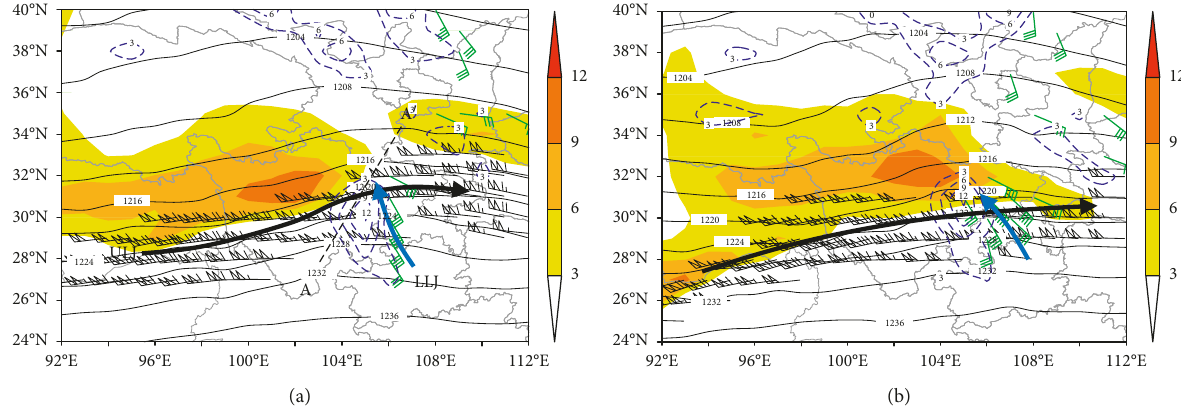
6–622°N24°N26°N28°N30°N32°N34°N36°N38°N 1 ), 24-h temperature variation (shaded, ° C), divergence value of less than Figure 5: 850hPa wind field (m s · and PEPTdistribution (black solid line, ° C) at (a) 1800 UTC 26 October 2014, (b) 0000 UTC 27 October 2014, (c) 1200 UTC 27 October 2014, − and (d) 0000 UTC 28 October 2014. L—SWCV; J—LLJ. The thick solid line (black) and the curve with an arrow in (b)—inverted trough and its airflow direction; the thick solid line (red) in (d)—shear line; grey area—terrain of Tibetan Plateau. Figure 6: